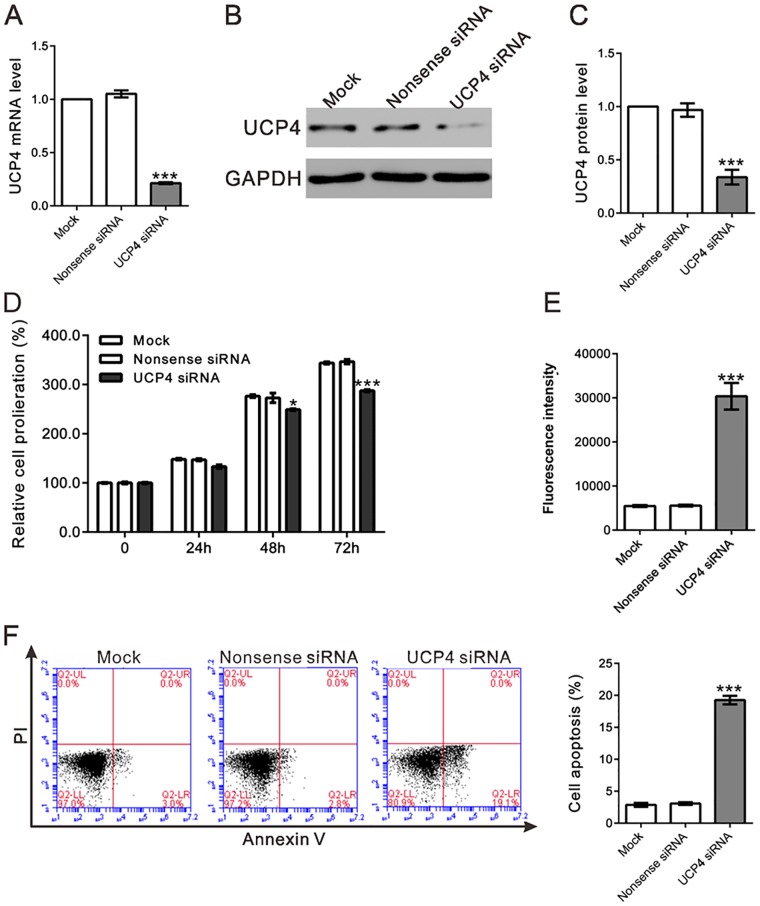
UCP4-specific siRNA induced apoptosis of rat chondrocytes.(A-C) Rat chondrocytes were treated with UCP4-specific siRNA for 48 h. mRNA and the protein level of UCP4 were detected using real-time PCR (A) and western blotting assay (B, C). UCP4 expression in control chondrocytes without treatment (Mock) was fixed at 1.0. (D) Cell proliferation was detected in siRNA treated and untreated chondrocytes by CCK-8 assay. Results of cell growth were normalized to the initial cell numbers (100%). (E, F) Chondrocytes were transfected with indicated siRNA for 48 h. Intracellular ROS and cell apoptosis rate was analyzed on a flow cytometry. *P <0.05 and ***P <0.001 versus Nonsense siRNA-treated cells.